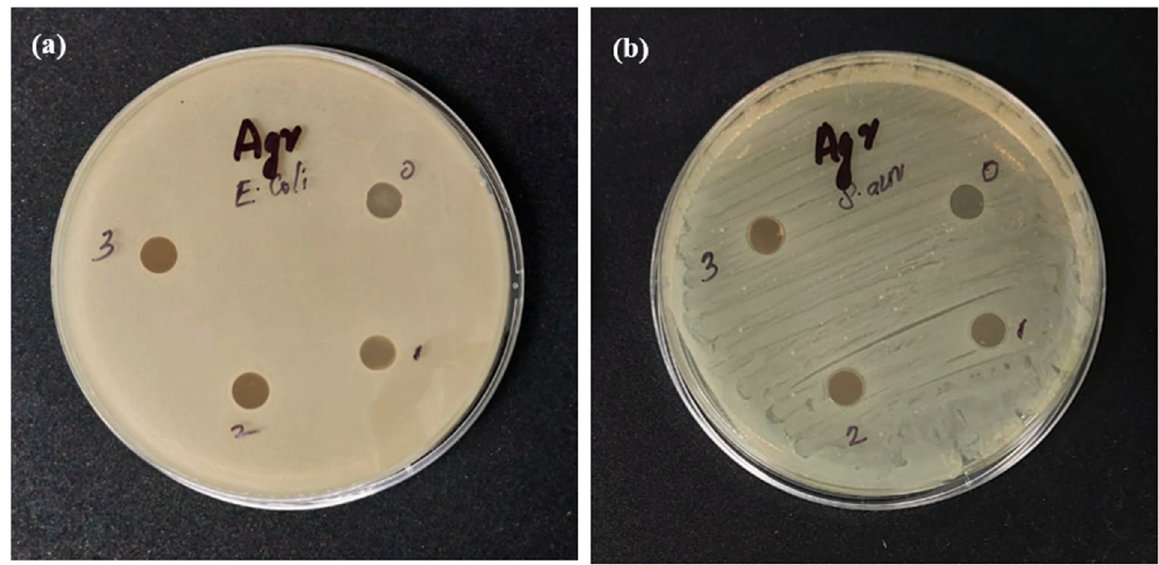
Figure 7. Optical microscopy images of biomembrane: ( a ) AG-0; ( b ) AG 1; ( c ) AG-2; ( d ) AG-3.